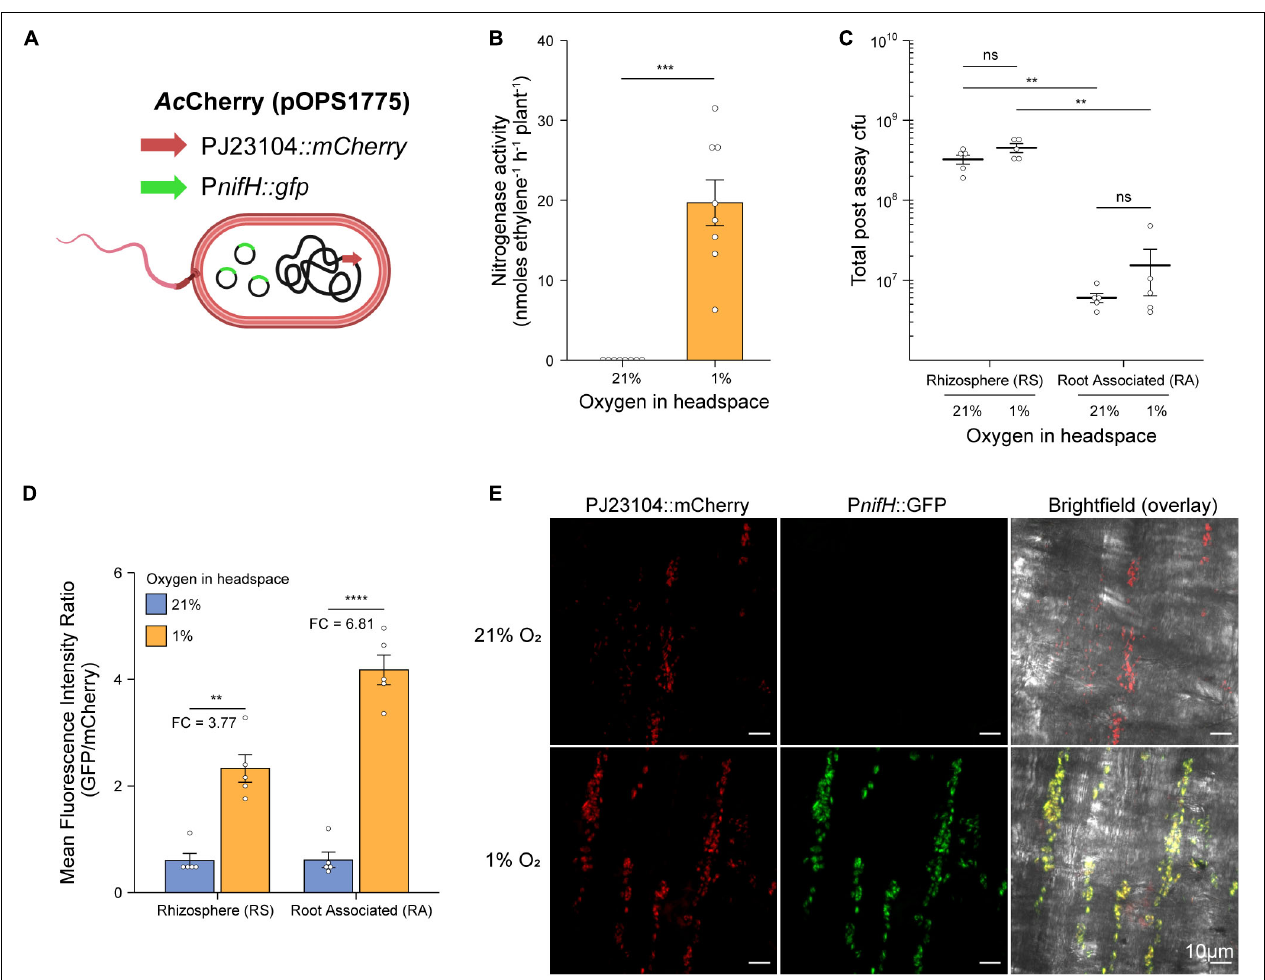
FIGURE 3 | Rhizosphere and root associated nitrogenase expression during in situ ARAs. To assess spatial expression of nitrogenase in our in situ ARA systems, (A) we marked the chromosome of strain Ac LP with a constitutively expressed mCherry cassette derived from pOPS1531 and introduced into the resulting strain ( Ac Cherry) plasmid pOPS1775 which carried the promoter of the nitrogenase structural gene nifH fused to a GFP reporter. It was previously shown that expression from P nifH is induced under N-fixing (low O 2 and N) conditions (Kaminski and Elmerich, 1991; Michel-Reydellet and Kaminski, 1999), thus comparison of GFP fluorescence in in situ ARAs performed with a headspace of 1% vs. 21% could be used to assess nifH expression. (B) Mean ± SEM (error bars) rates of nitrogenase activity derived from eight in situ ARAs of Ac Cherry (pOPS1775) inoculated at OD 600 nm 0.1 onto barley. (C) Estimated population sizes of bacteria occupying the rhizosphere and soil (RS) or rhizoplane and endosphere (root associated, RA) from five plants on which in situ ARAs were performed. (D) Comparison of standardized P nifH::gfp expression (mean GFP/mCherry fluorescence intensity ratio) by flow-cytometry of bacteria occupying the RS and RA fractions from the same five plants in which in situ ARAs were performed. Values for fold-changes (FC) in expression are provided (E) Maximum intensity projections showing mCherry and GFP fluorescence by Ac Cherry (pOPS1775) cells colonizing the rhizoplane of plants on which in situ ARAs were performed. Each image is representative of 15 images acquired from five whole lateral roots excised from three plants per treatment. ANOVA and two-tailed student’s t -tests with Bonferroni adjusted P -values were used to compare means where relevant. P > 0.05 not significant (n.s.), * P < 0.05, ** P < 0.01, *** P < 0.001, and **** P < 0.0001. Panel A was created using BioRender R (cid:13)